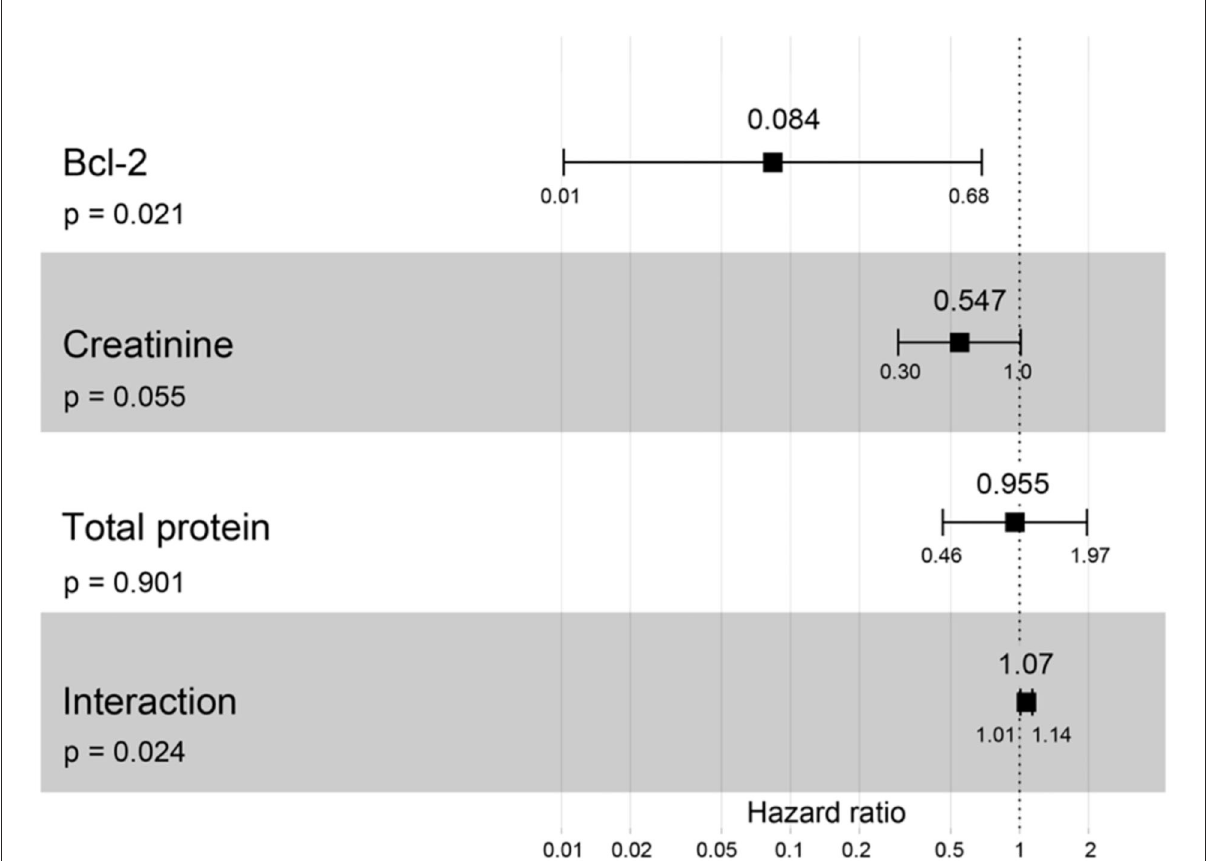
FIGURE12 Forest plot output for the interaction of Bcl-2 with two different covariates (creatinine and total protein) with CKD progression based on hazard ratios (HRs) via Cox regression analysis. Squares represent hazard ratios. Bars represent 95% confidence